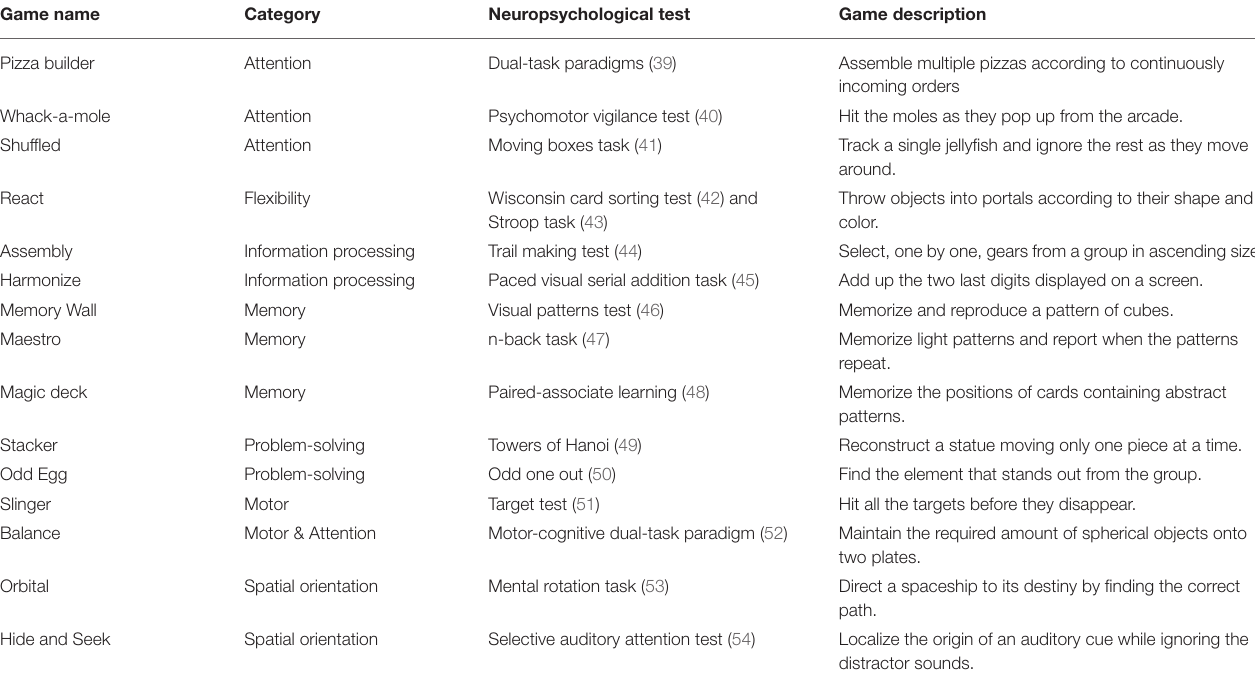
TABLE 1 | Enhance VR game